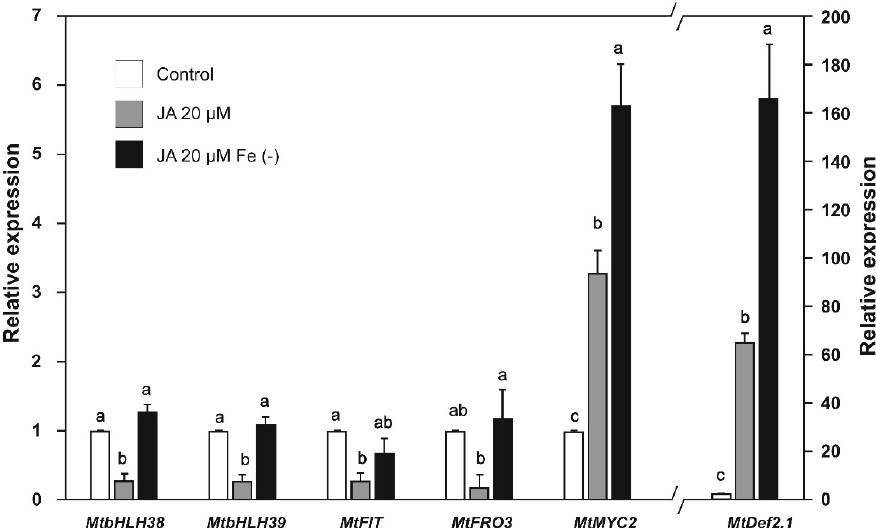
Figure 7. Relative expression of iron uptake and defense genes in Medicago truncatula plants grown with jasmonic acid (20 μ M) under both iron-sufficient and iron-deficient conditions for 48 h. Values represent mean ± standard errors of relative expression in reference to controls. Values of MtDef2.1 expression are shown on the axis on the right. Different lowercase letters indicate significant differences as determined by one-way ANOVA and Tukey’s test ( p < 0.5; n = 3).